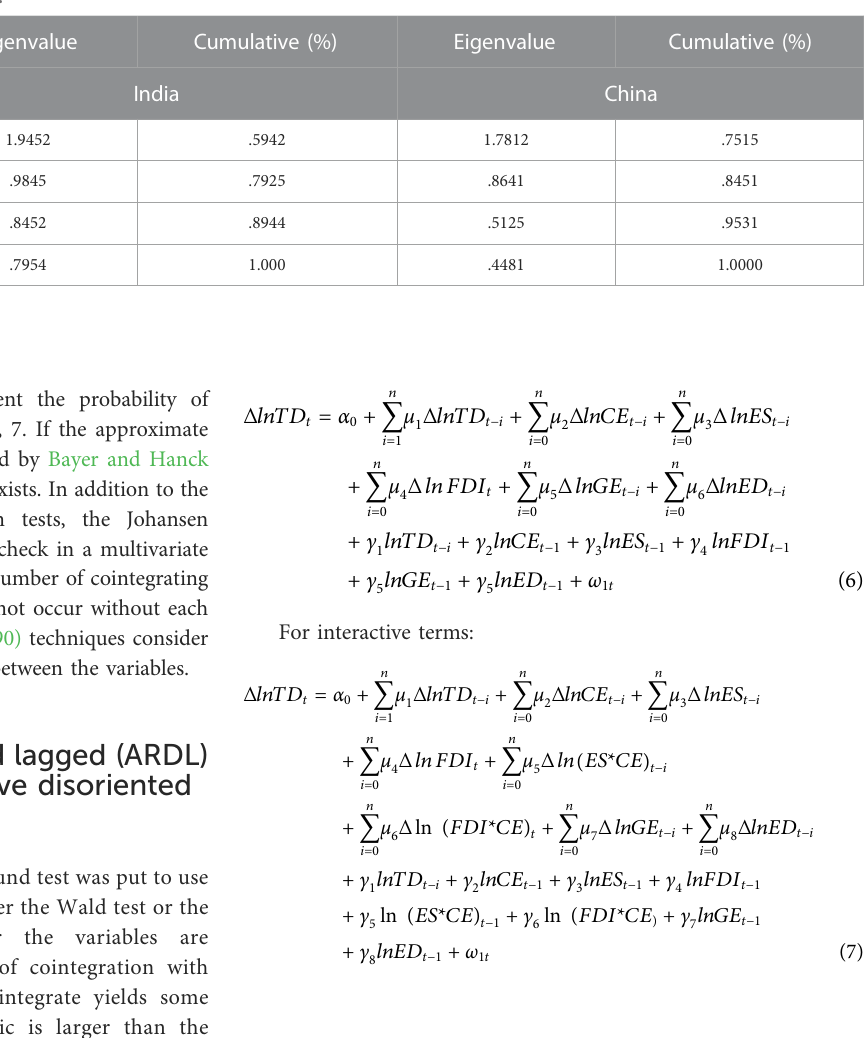
TABLE 2 Results of PCA for fi nancial inclusion